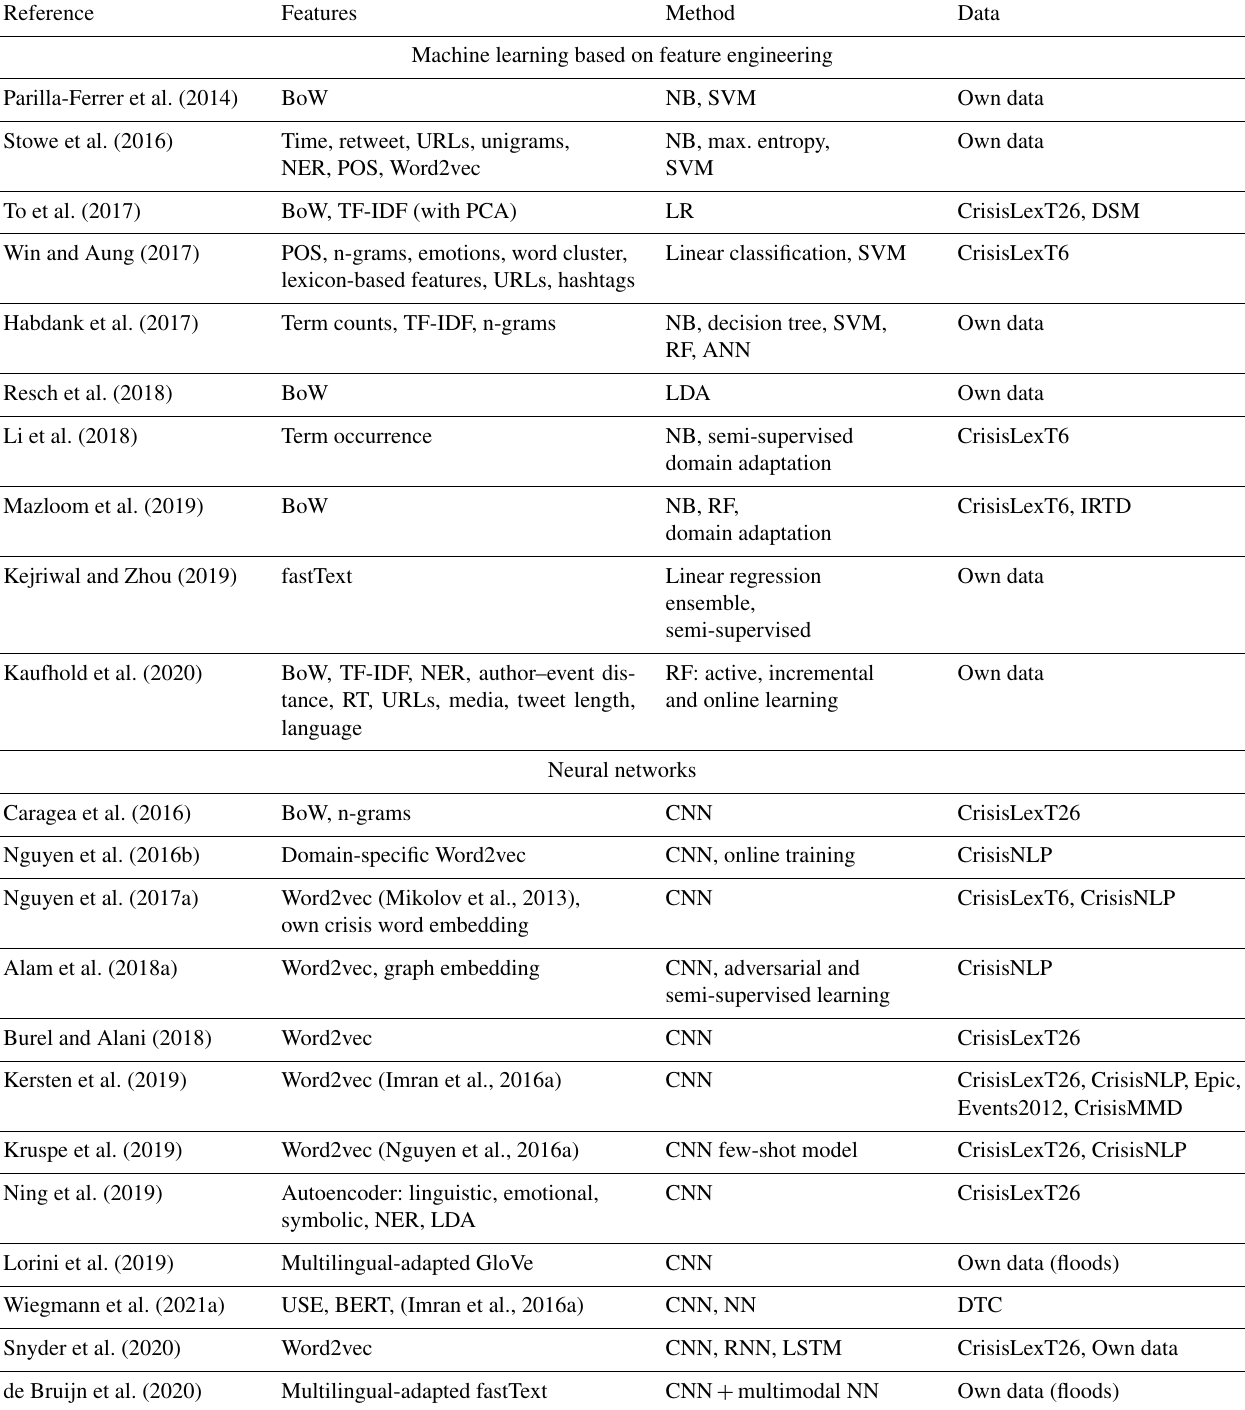
Table 3. Overview of the related work proposing filtering algorithms, ordered by the employed method, and listing the data sets